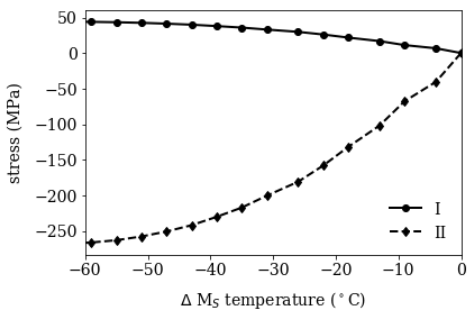
Figure 7. Residual stresses after cooling in depleted (I) and segregated (II) region for pure martensite as function of difference in martensite start temperature ∆ M s